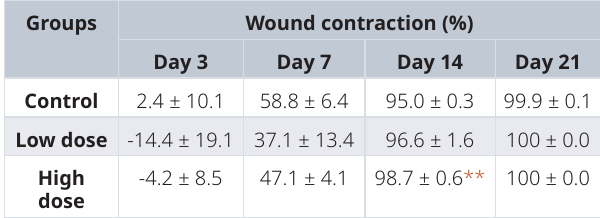
Table 3. Percentage wound contraction for animals receiving low and high dose extracts vs controls.